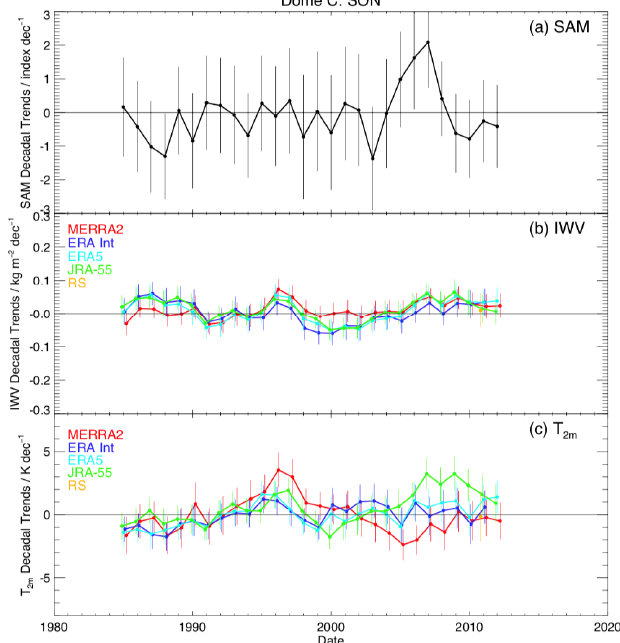
Figure 12. Multidecadal variability of the 10-year trends of ( a ) the SAM index, ( b ) the IWV and ( c ) the near-surface temperature (T 2m ) from the MERRA2 (red), ERA interim (dark blue), ERA5 (light blue) and JRA-55 (green) reanalyses above Dome C from 1980 to 2017 in spring (SON). Superimposed are the 10-year trends of the IWV ( b ) and the 10-m temperature ( c ) from the radiosonde data set (orange) from 2005 to 2017. Vertical bars represent 1- σ error.